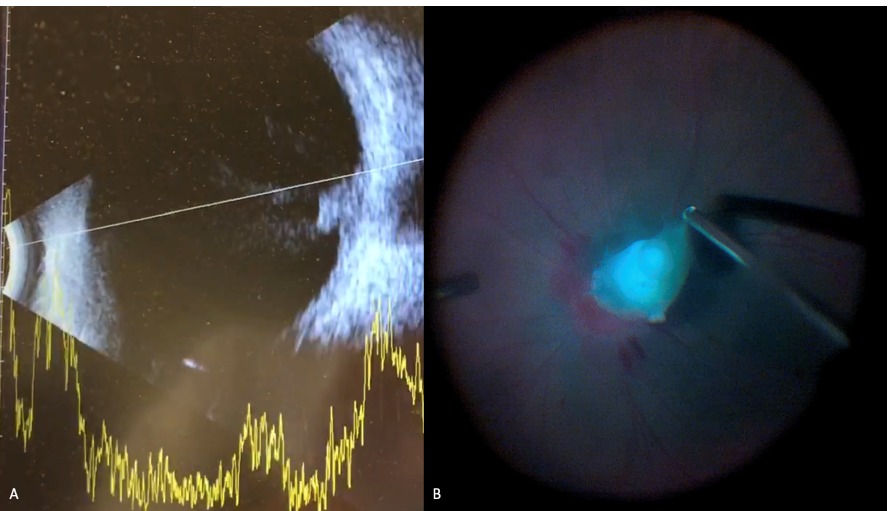
Figure 5. Ophthalmic B-scan showing ( A ) an endophytic lesion on optic nerve head and vitreous opacification ( B ) intra-operative view during surgical removal of large endophytic fungal ball that was previously identified on B-scan.